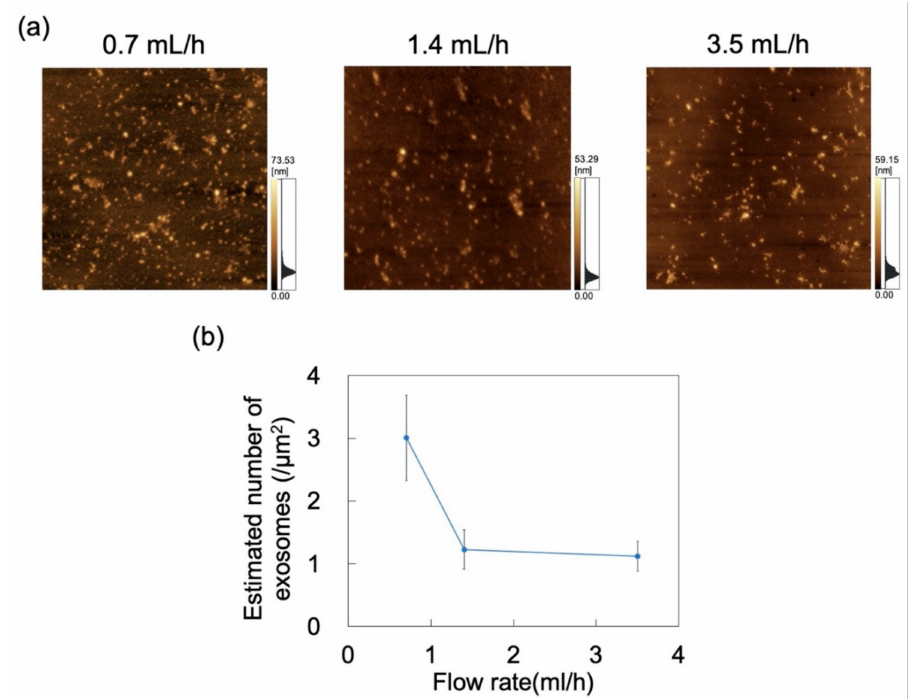
Figure 10. Adsorption of exosomes on polydimethylsiloxane (PDMS)-based microchannels at pH 6 and flow rates of 0.7, 1.4, and 3.5 mL/h. ( a ) AFM images of PDMS-based microchannels. Scan area = 8 µ m × 8 µ m. ( b ) Number of exosomes adsorbed on PDMS-based microchannels ( n = 5) as a function of flow rate. Error bars represent the standard